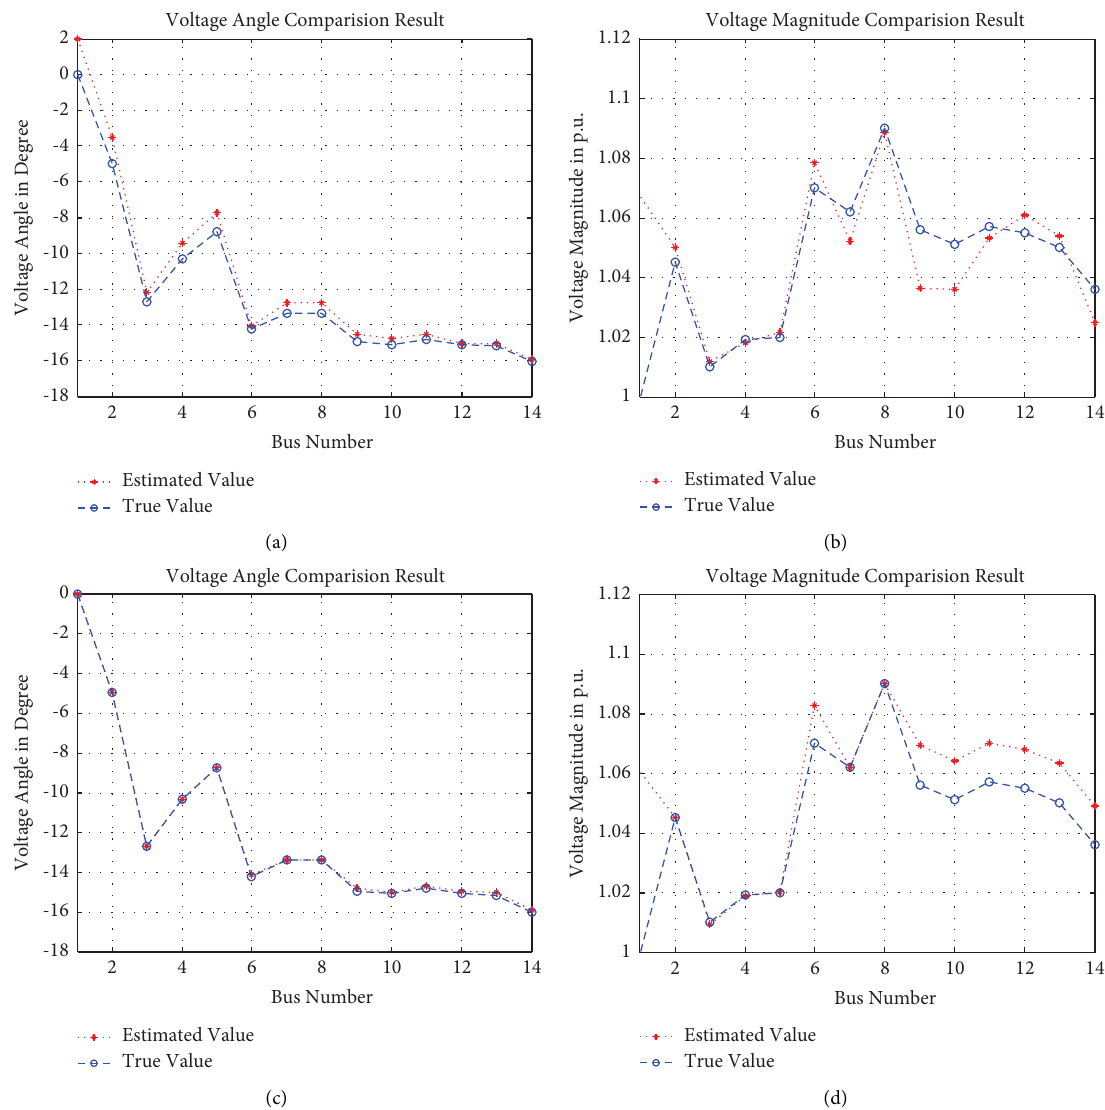
Figure 1: Comparison of true and estimated values for the magnitude and phase of the voltage of busbars in the 14-bus network by performing scenarios 5 and 6 without applying an outlier. (a) Phase of busbars voltage—scenario 5. (b) Magnitude of busbars volta- ge—scenario 5. (c) Phase of busbars voltage—scenario 6. (d) Magnitude of busbars voltage—scenario